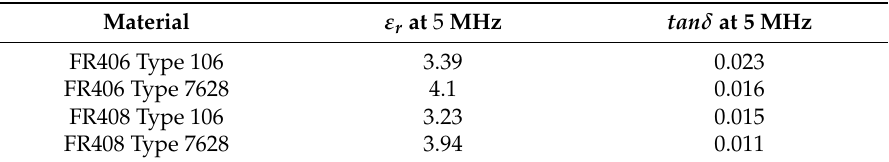
Table 3. Relative permittivity and tangent loss.